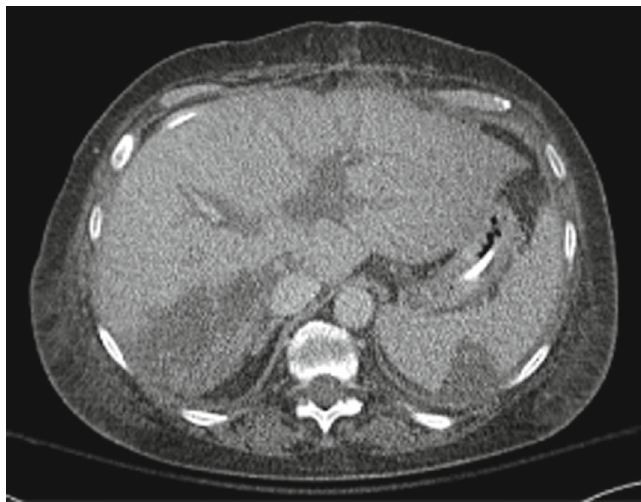
Figure 2: Splenic infarct